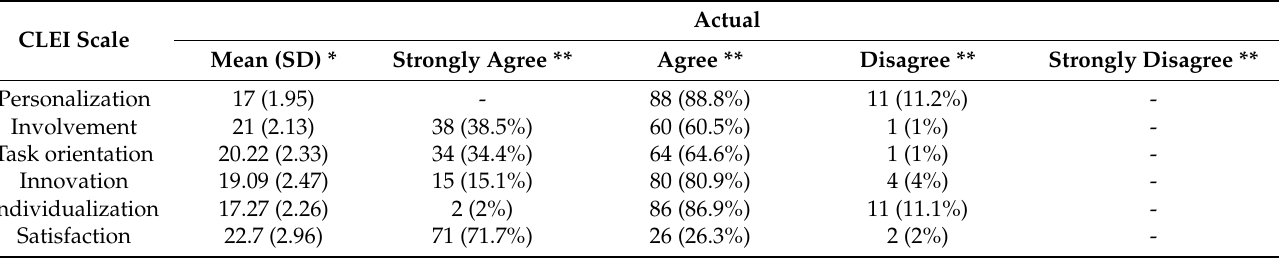
Table 2. Frequency score of the CLEI-Actual ( n =